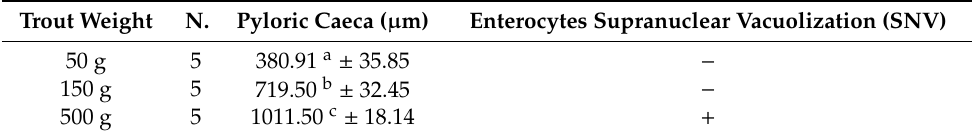
Table 2. Evaluation of pyloric caeca histometry in rainbow trout along the first year of development. Trout Weight N.